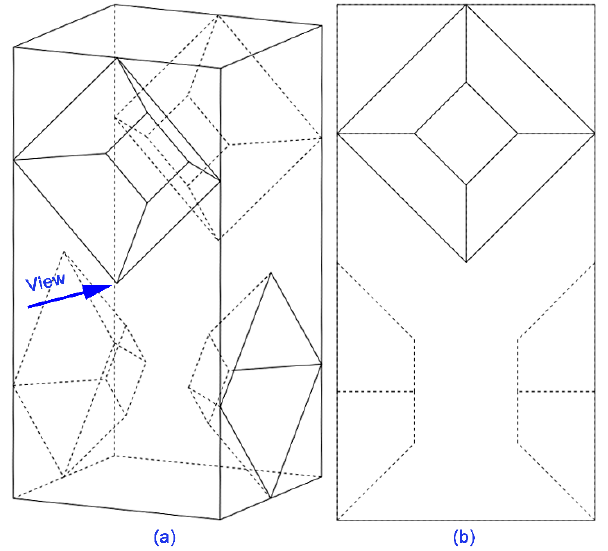
Figure 3. The internal structure designed for the reaction pipe: ( a ) the isometric view; ( b ) the elevation view.